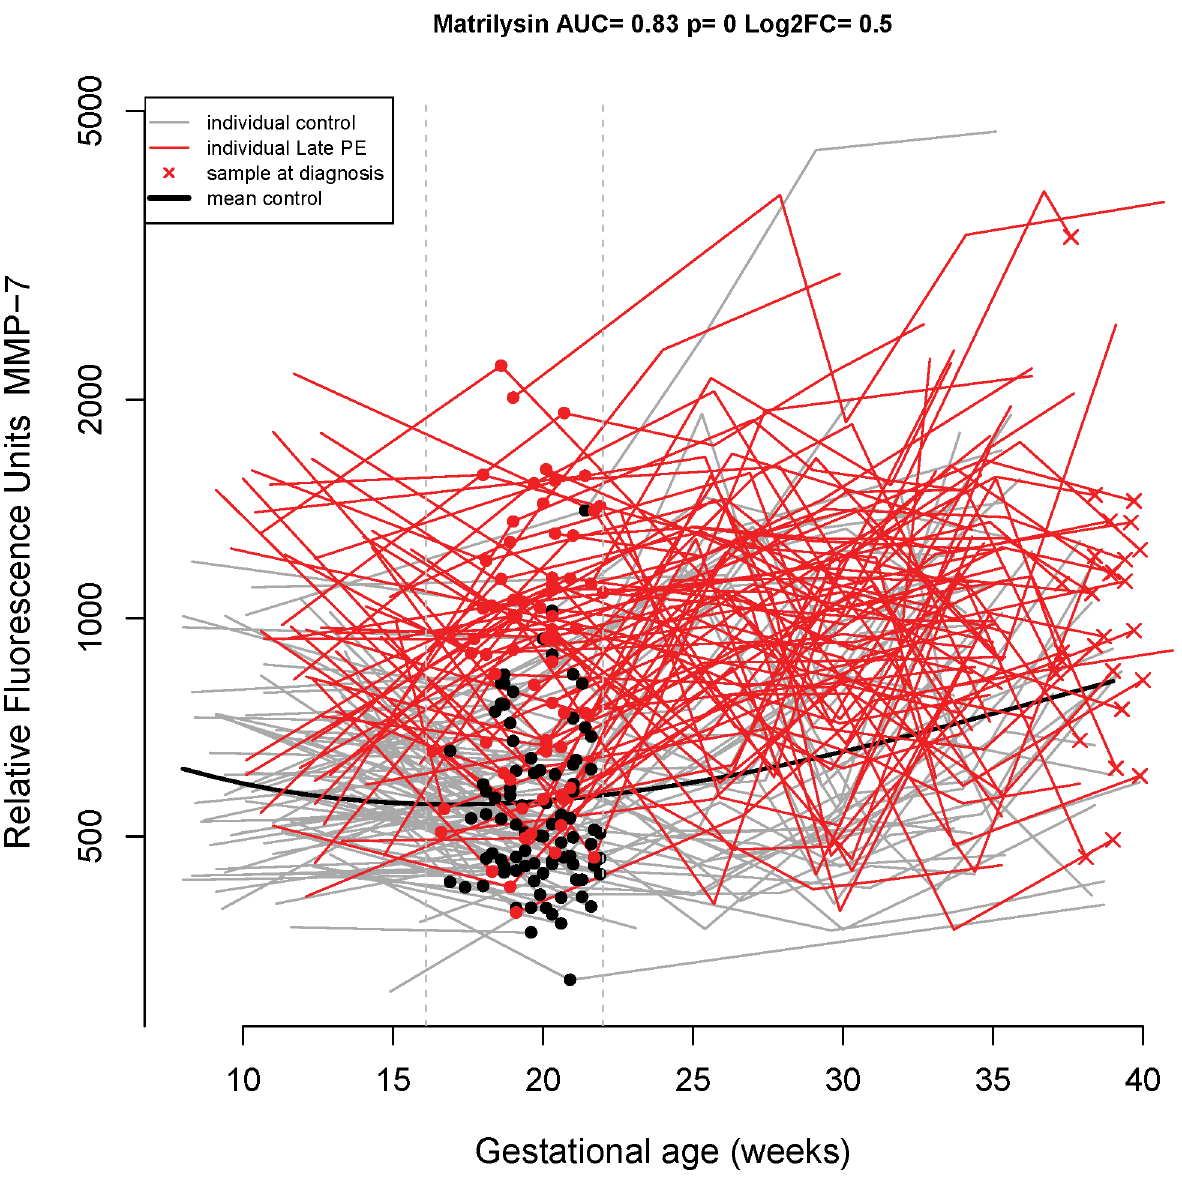
Fig 3. Longitudinal maternal plasma MMP-7 abundance in normal pregnancy and late-onset preeclampsia cases, highlighting differences in the 16.1–22weeks interval. See the Fig 1 legendfor more details.